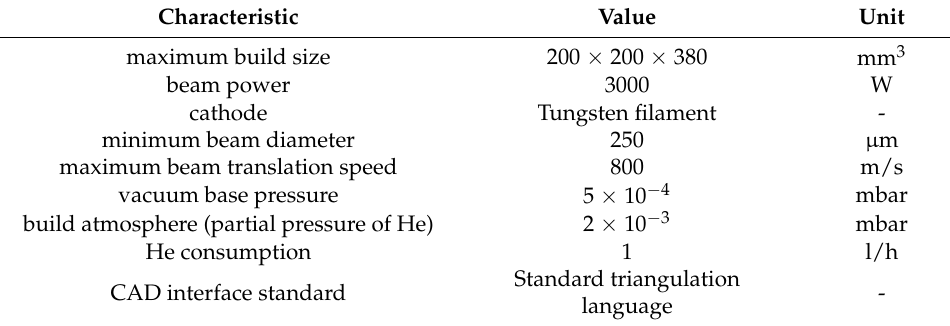
Table 1. Main characteristics of Arcam A2X